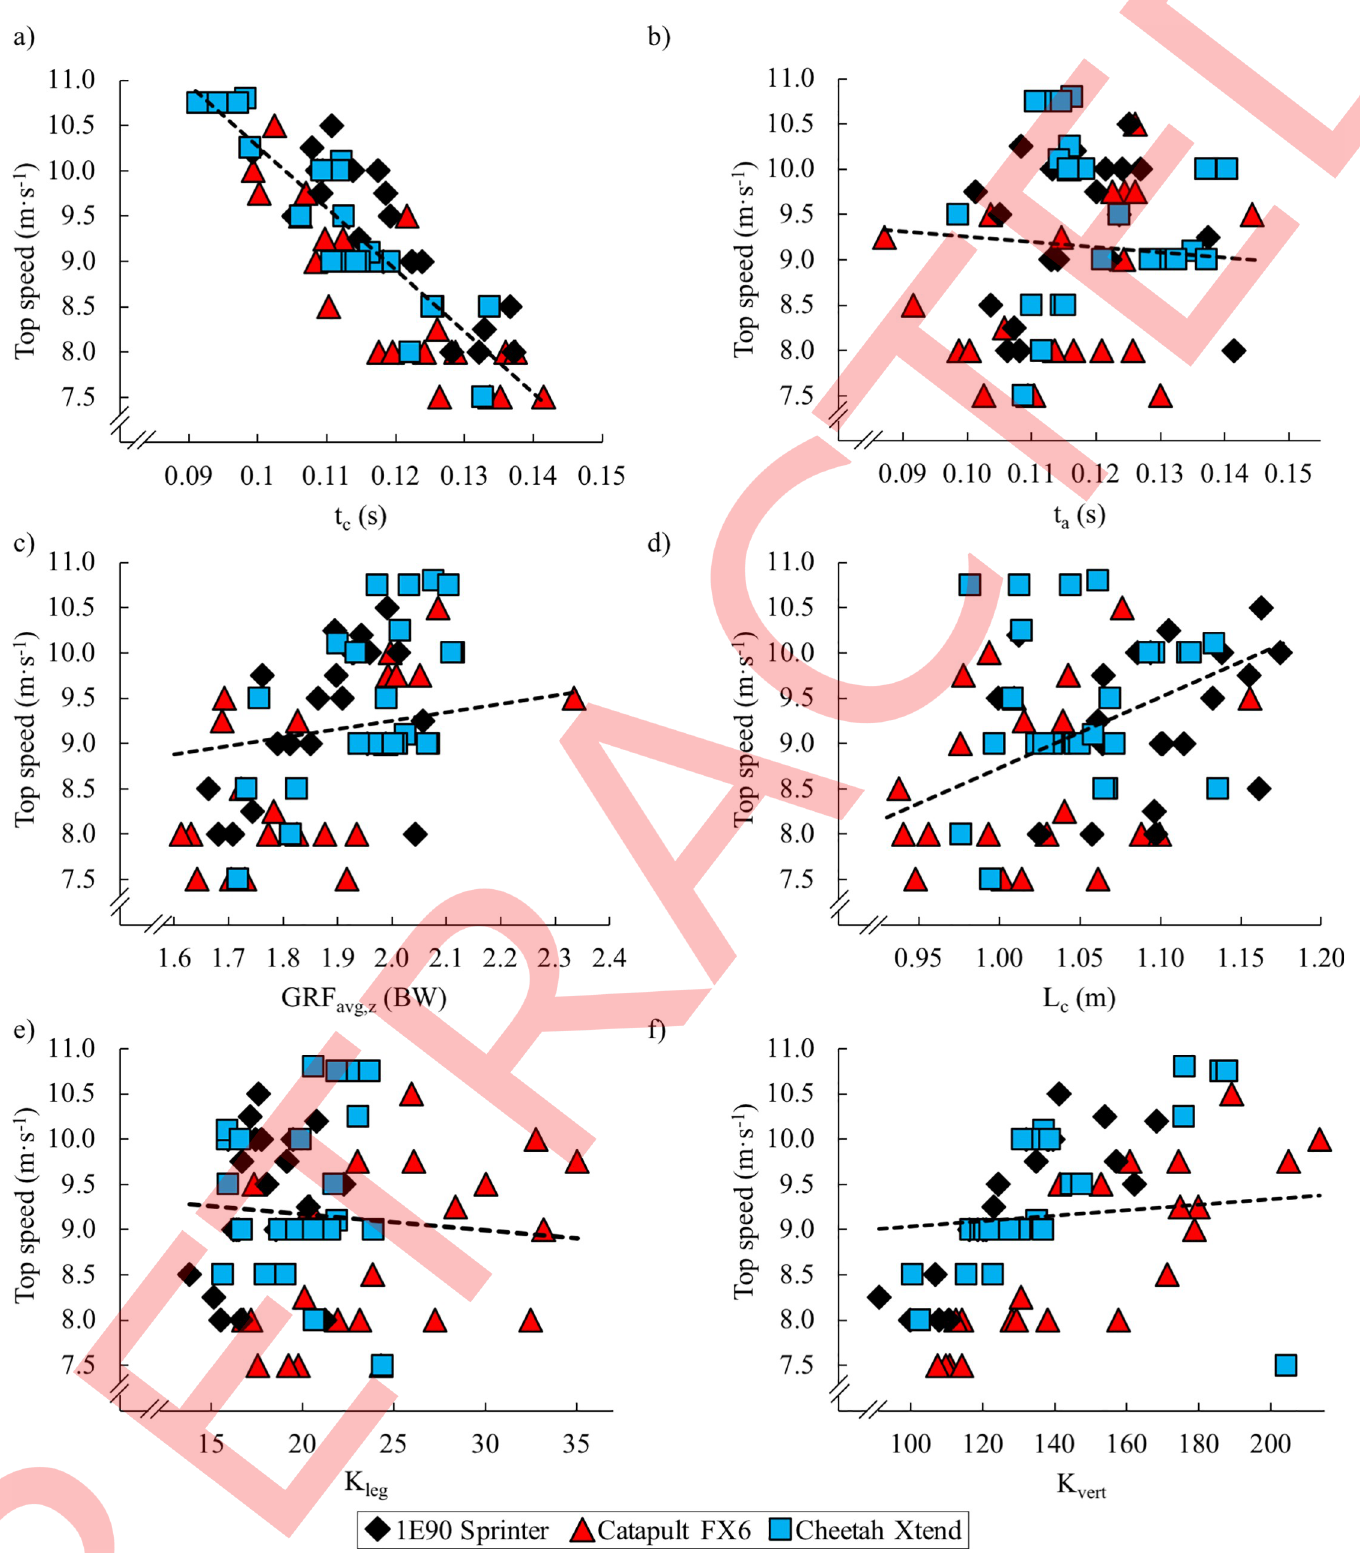
Fig 3. Maximum speed as a function of: a) contact time (t c ), b) aerial time (t a ), c) stance average vertical ground reaction force (GRF avg,z ), d) contact length (L c ), e) dimensionless leg stiffness (K leg ), and f) dimensionless vertical stiffness (K vert ). Each data point represents a single subject and RSP model. The dashed lines